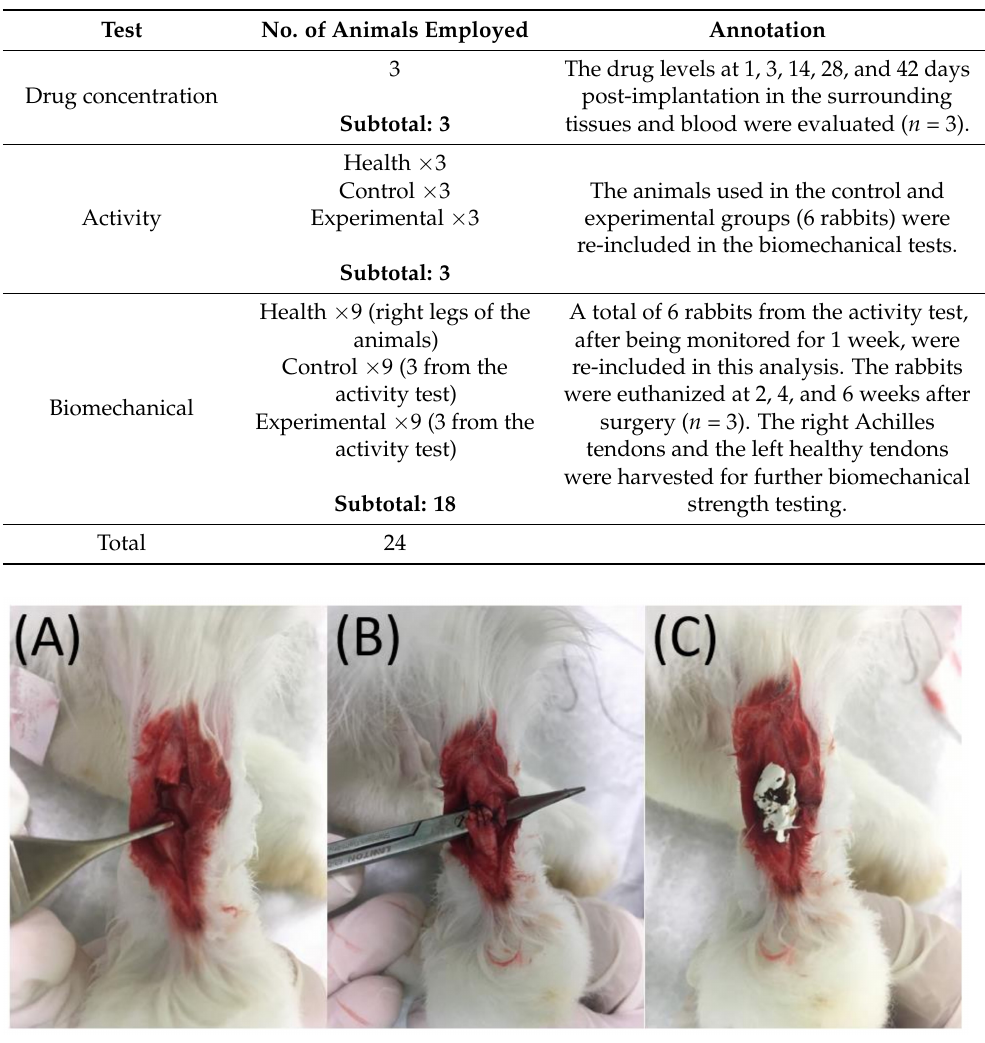
Figure 1. ( A ) The Achilles tendon was cut using a blade. ( B ) The tendon was primarily repaired with Dexon sutures, and ( C ) enveloped with doxycycline-embedded